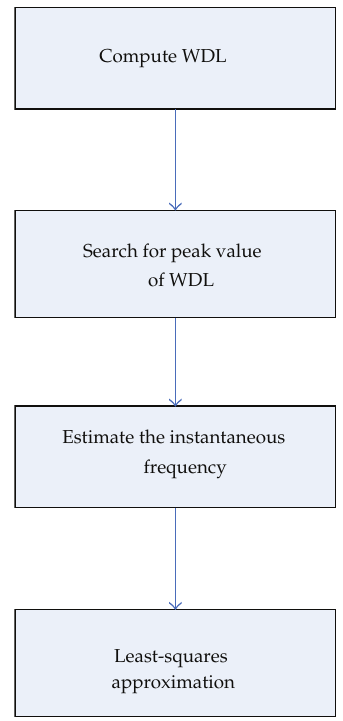
Figure 1: Detection algorithm diagram of instantaneous